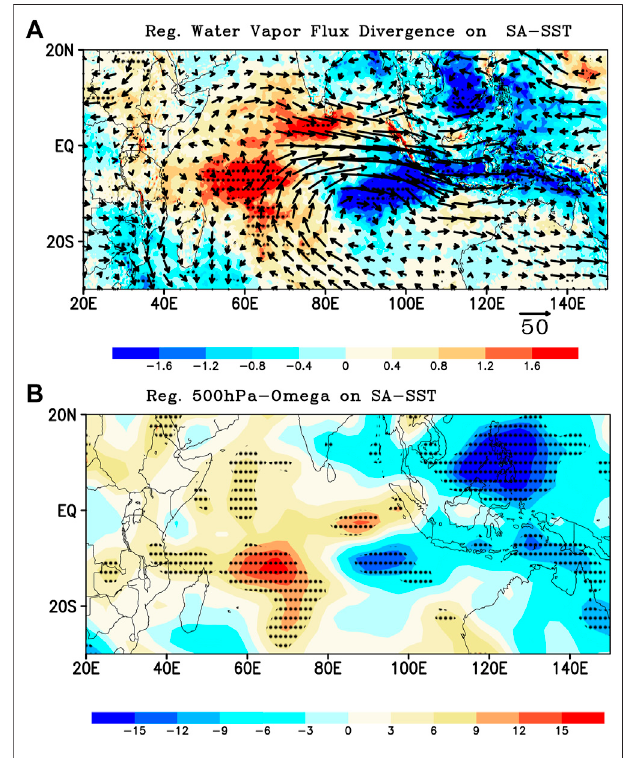
FIGURE 13 | Regressions of (A) divergence (10 − 5 kg s − 1 m − 2 ) of water